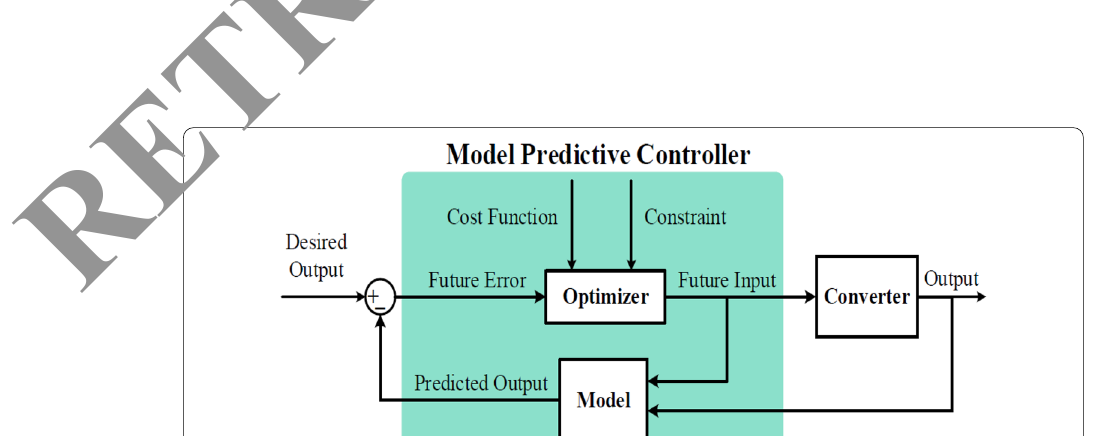
Fig. 14 Basic structure of model predictive